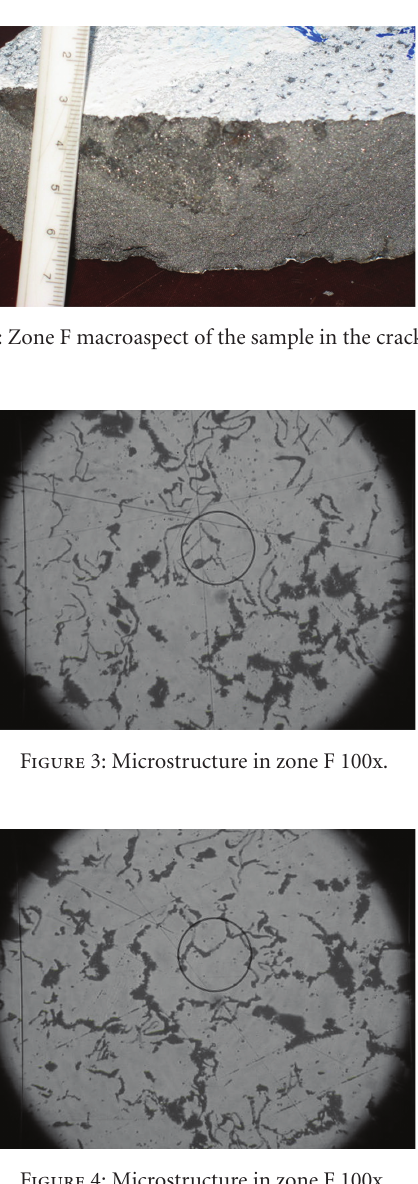
Figure 7: Macroaspect of the sample in zone